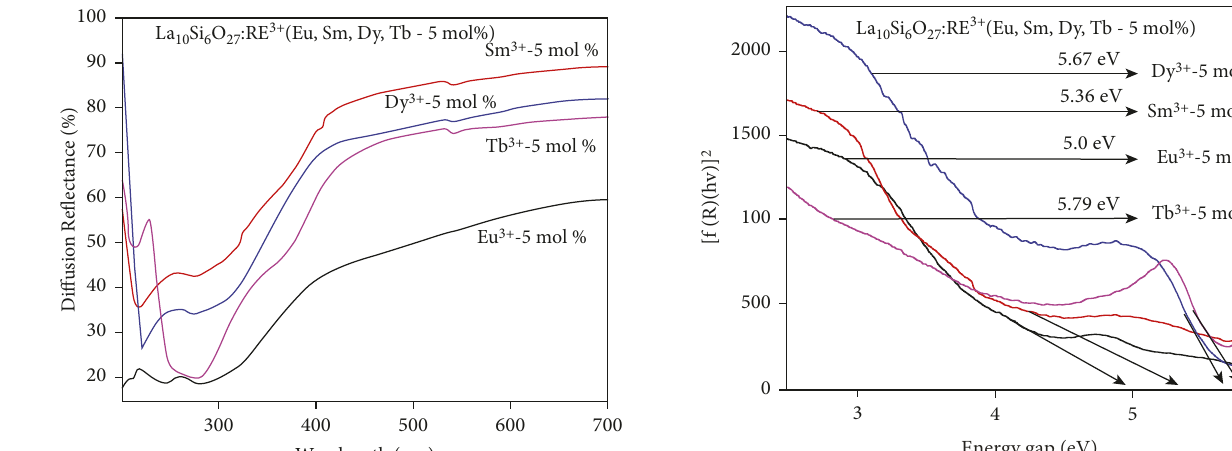
3+ (Eu, Sm, Dy, and Tb 10 Si 6 O 27 :RE